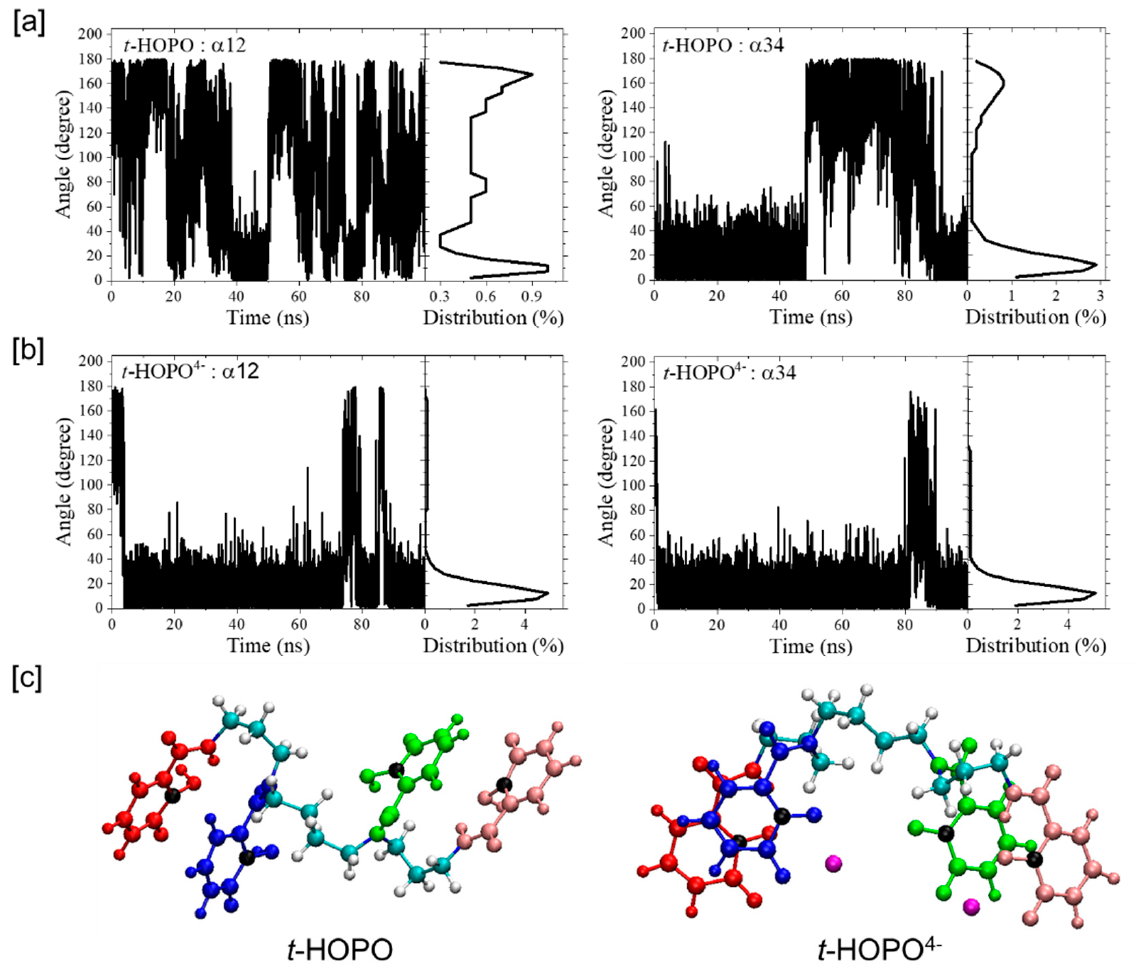
Figure 3. The time evolution of the angles between Plane1 and Plane2 ( α 12 ), and between Plane3 and Plane4 ( α 34 ), and their populations in the simulations of t -HOPO in its neutral ( a ) and deprotonated ( b ) states. The typical conformations with two planes parallel ( α ij ~0 ◦ ) or anti-parallel ( α ij ~180 ◦ ) to each other in t -HOPO and t -HOPO 4 − are also shown ( c ). Color scheme: Plane1 in red, Plane2 in blue, Plane3 in green, Plane4 in pink, N atoms in each ring in black, Na + in purple.